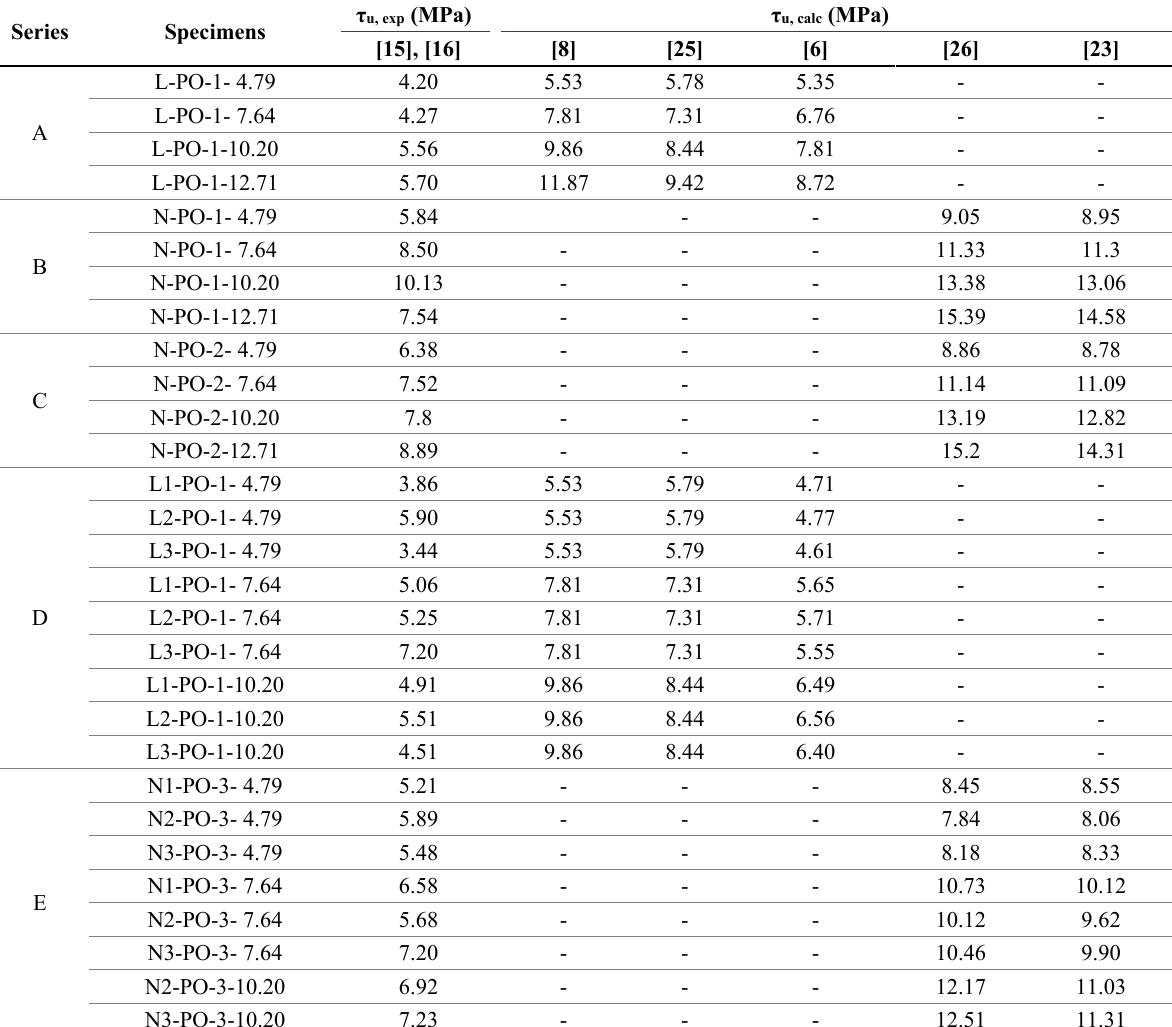
Table 3. Ultimate shear strength values obtained experimentally and the calculated values of proposed